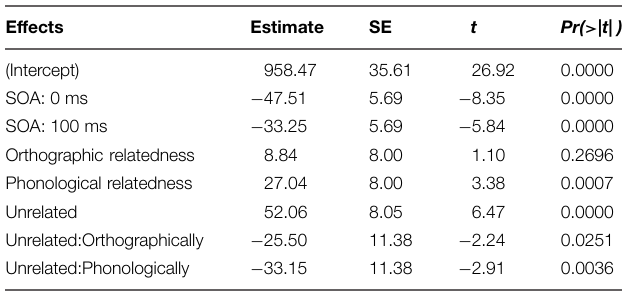
TABLE 2 | Summary of fixed effects in the linear mixed-effects model for onset latencies in Experiment